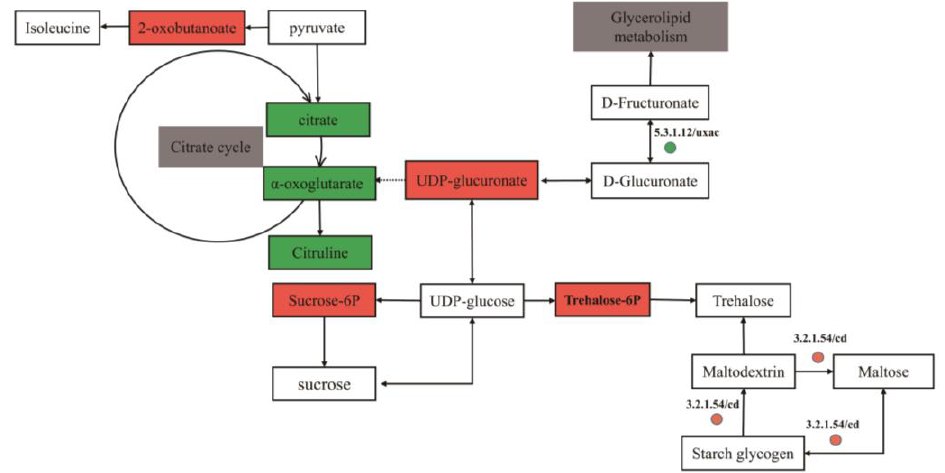
Figure 9. Carbohydrate metabolism and amino acid metabolism pathways based on multi-omics analysis of heat-resistance in RS047-wl. Color rectangles are the relative content changes of metabolites in RS047-wl compared to WT RS047 (red, higher content; green, lower content; white, no significant change); the colored circles represent the gene expression levels in RS047-wl compared to WT RS047 (green, lower content; white, no significant change).